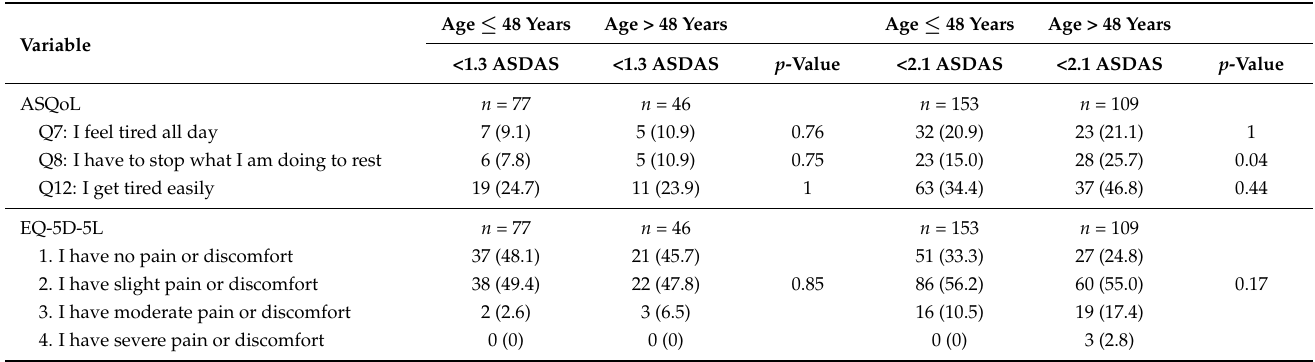
Table 6. Quality of life in patients with axial spondyloarthritis using ASQoL and EQ-5D-5L stratified by age and ASDAS.